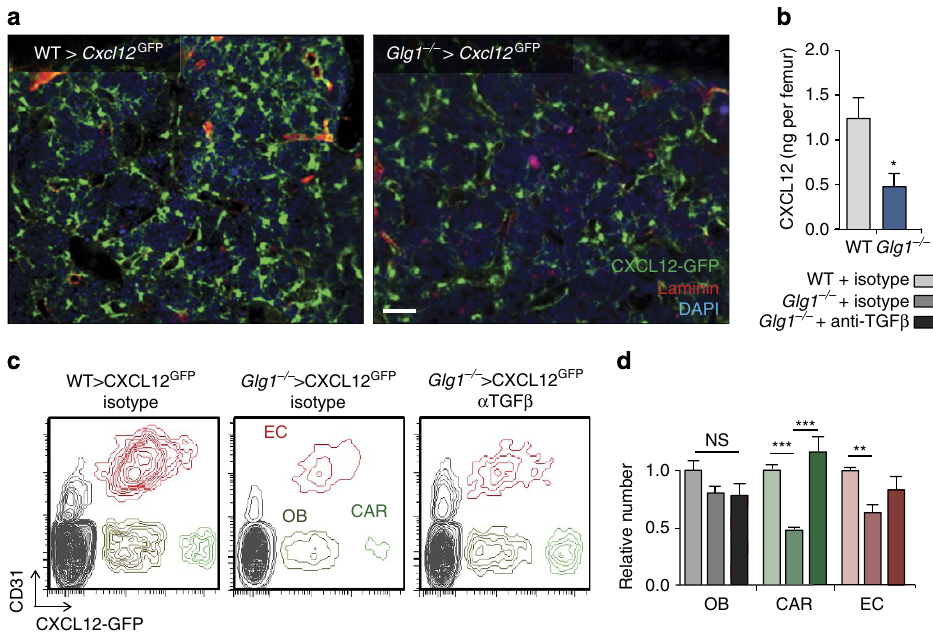
Figure 6 | Haematopoietic ESL-1 preserves the CXCL12-producing bone marrow stroma. ( a ) Whole-mount staining of sternal BM of Cxcl12 GFP mice transplanted with WTor Glg1 (cid:2) / (cid:2) bone marrow cells; n ¼ 4. Scale bar, 50 m m. ( b ) CXCL12 protein levels in the BM mice transplanted with WTor Glg1 (cid:2) / (cid:2) bone marrow cells; n ¼ 5. ( c ) Representative density plots showing osteoblasts (OB), CAR and endothelial cells (ECs) in the bone marrow of the BM of Cxcl12 GFP mice reconstituted with WT or Glg1 (cid:2) / (cid:2) BM, and treated or not with an anti-TGF b antibody for 2 weeks, and quantification of their relative numbers ( d ); n ¼ 5 mice per group. Data are shown as mean ± s.e.m.; * P o 0.05; ** P o 0.01; *** P o 0.001 as determined by Student’s t -test ( b ), or one-way analysis of variance with Turkey’s test ( d